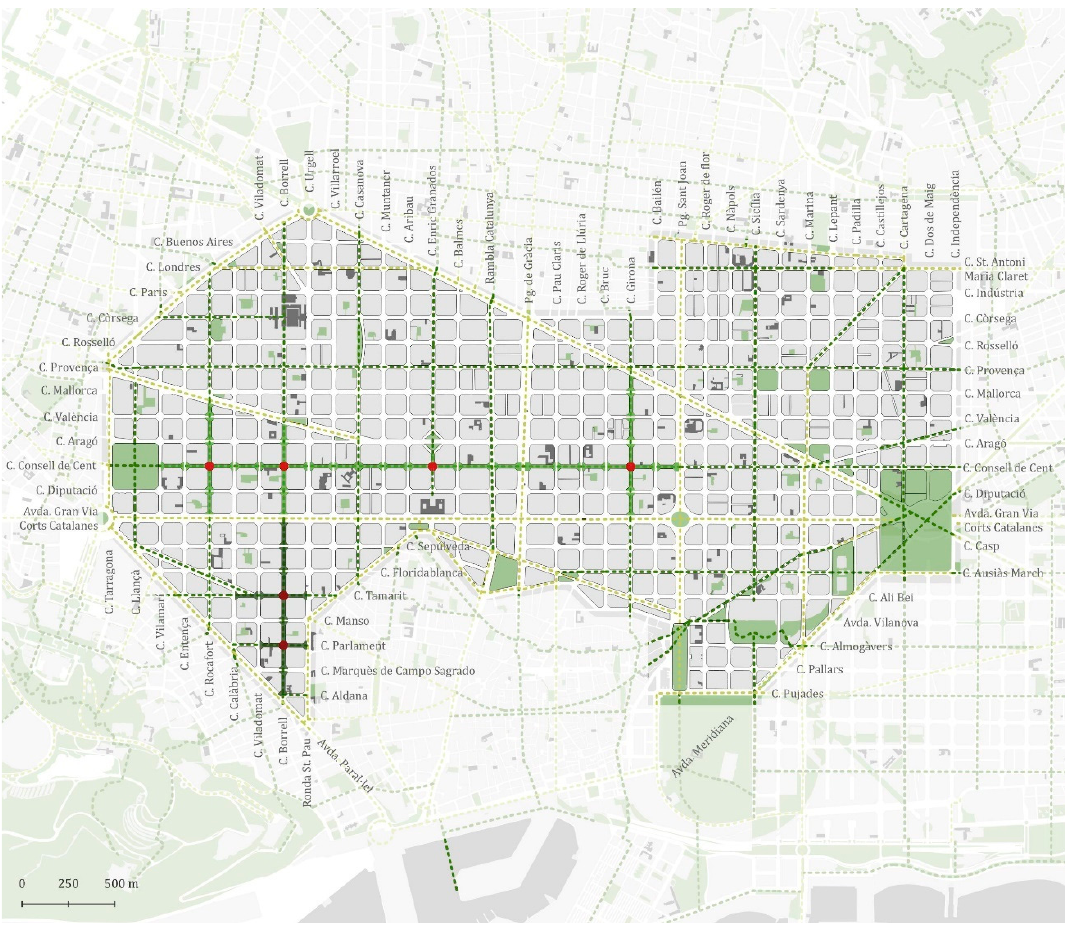
Figure 11. Plan to execute 21 km of green axes in L’Eixample district before 2030. Green axes executed in Sant Antoni in 2018 (dark green), green axes (continuous green lines) and square gardens (red dots) to be built by 2023, and planned green axes (dashed green lines) [82].